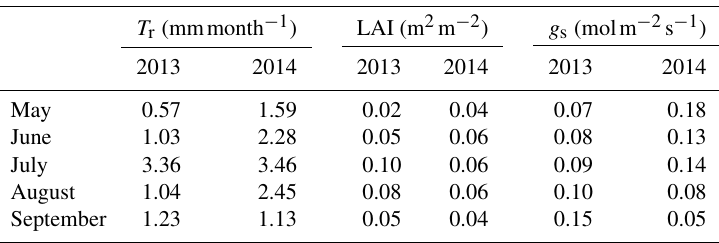
Table 1. Seasonal changes in transpiration ( T r ) per month, leaf area index (LAI), and stomatal conductance ( g s ) in Artemisia ordosica during the growing seasons (May–September period) of 2013 and